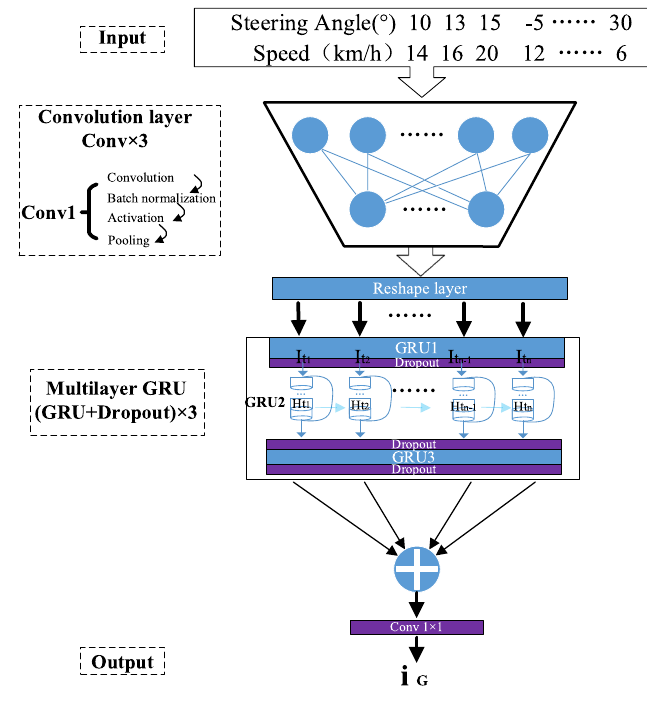
Figure 4. The structure of the vehicle driving state data extraction module (VSEM).